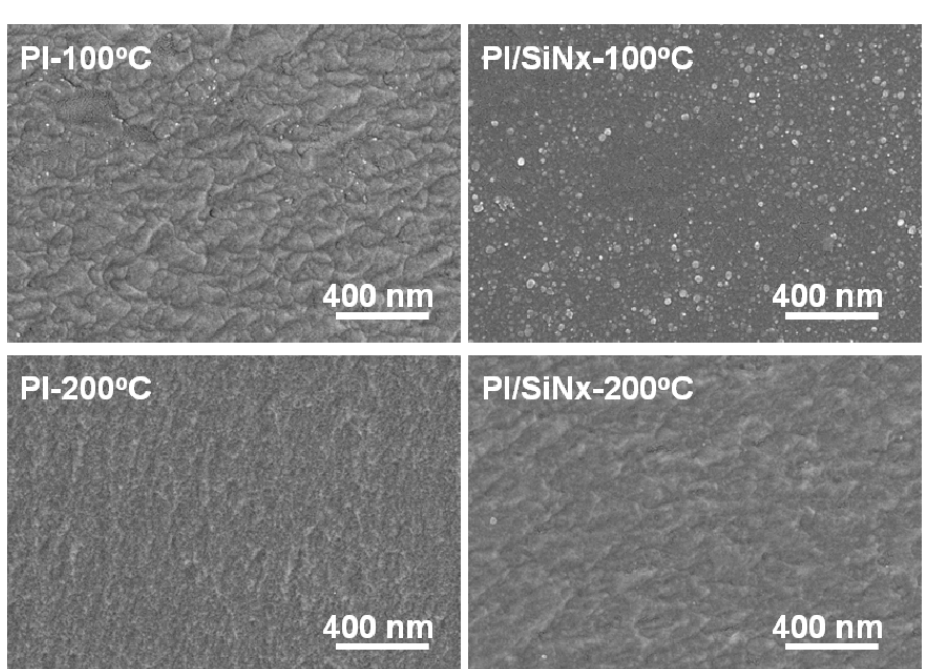
Figure 7. Surface morphologies of the un-etched GZO thin films deposited on different substrates as a function of deposition